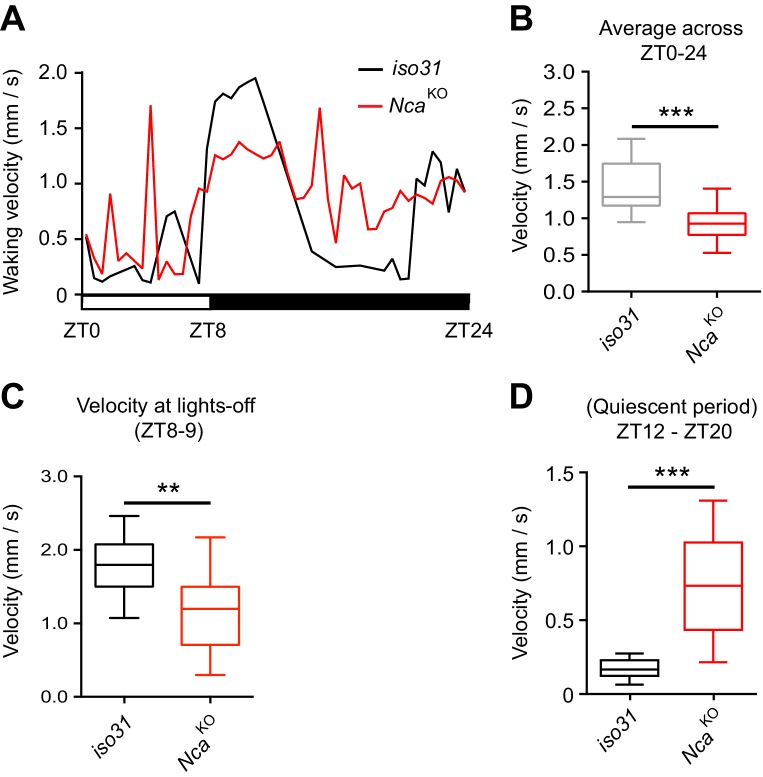
Locomotor velocities in Nca knockout flies.(A) Mean locomotor velocities across a 24 hr period in 8L: 16D conditions in NcaKO1 adult males and iso31 controls, measured via the DART system, reveals increased locomotor velocity during the night and reduced velocity during the evening activity peak NcaKO1 flies. (B) Median locomotor velocities across 24 hr in 8L: 16D conditions in NcaKO1 adult males and iso31 controls. (C) Median locomotor velocity is significantly reduced in NcaKO1 flies during the evening activity peak (ZT8-ZT9). (D) NcaKO1 flies exhibit a significant increase in locomotor velocity between ZT12-ZT20 compared to controls – a normally quiescent period. n = 16 per genotype. **p<0.01, ***p<0.001, Mann-Whitney U-test.